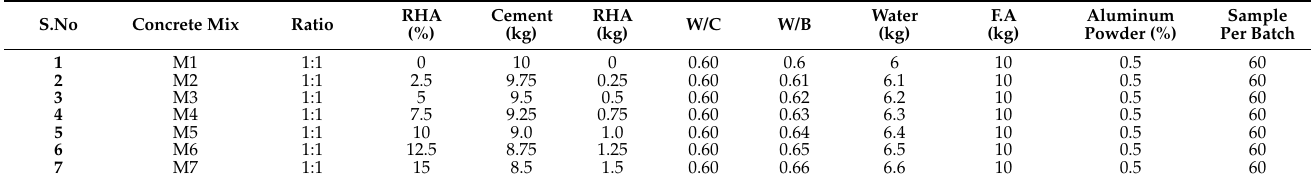
Table 2. Mixture proportion of control mix aerated concrete and rice husk ash aerated